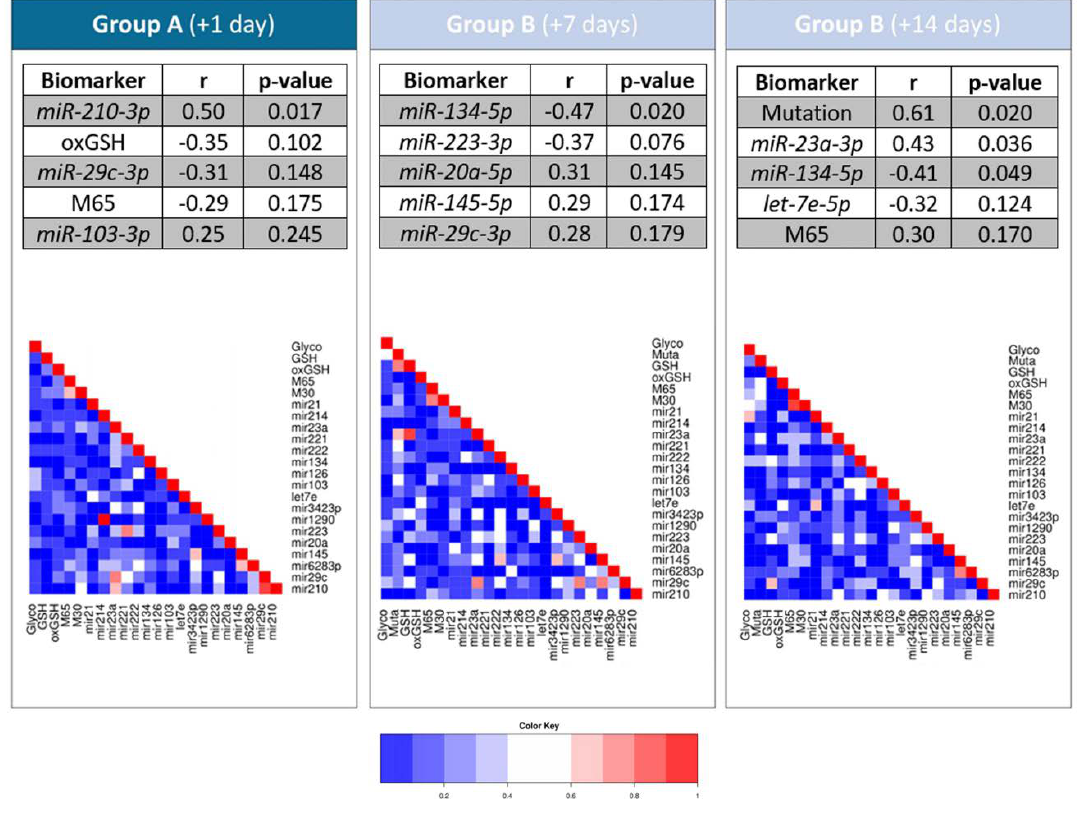
Figure 4. Predictive value of single markers at the three time points and correlation analyses. Linear regression analysis results of the individual markers at the three time points in relation to relative tumor load change from baseline to first CT after therapy. Heatmap indicates correlation between the single biomarkers (Pearson correlation).